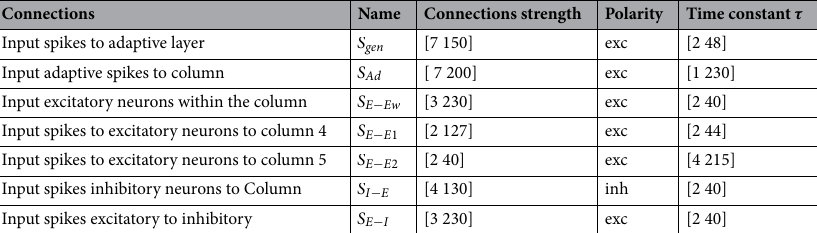
Table 1. Synapse parameters of column 3 of the network implemented on neuromorphic hardware. A connection between two neurons (Fig. 3b) is characterised by the positive (excitatory, exc) or negative (inhibitory, inh) current and the time constant. These parameters’ values [coarse and fine] are converted into currents using an 11-bits DAC (digital-to-analog converter) in which, the coarse value is encoded in 3-bits and the fine value is encoded in 8-bits. These currents are used to set the properties of the hardware circuits using the network.